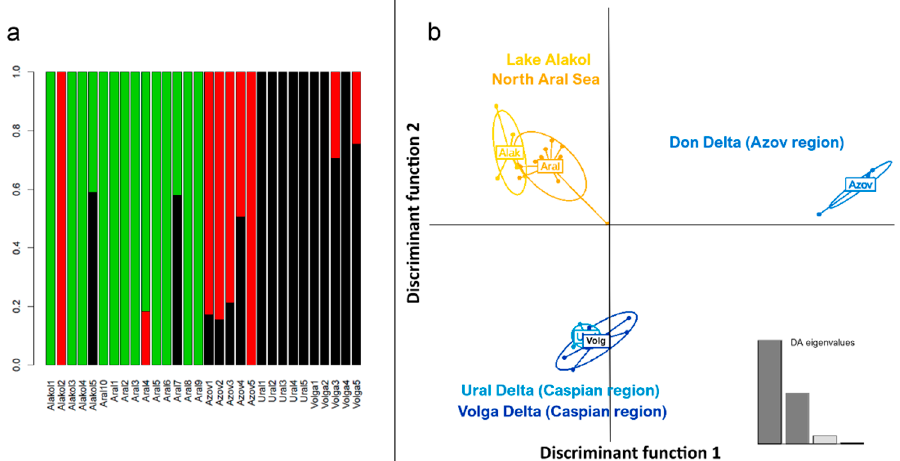
Figure 2. Analysis of wild common carp populations. ( a ) Population structure analysis of five com- mon carp populations. The y-axis shows the ancestry coefficients. ( b ) DAPC plot (discriminant anal- ysis of principal components) for Ponto-Caspian and Central Asian wild common carp populations based on individual genotypes.